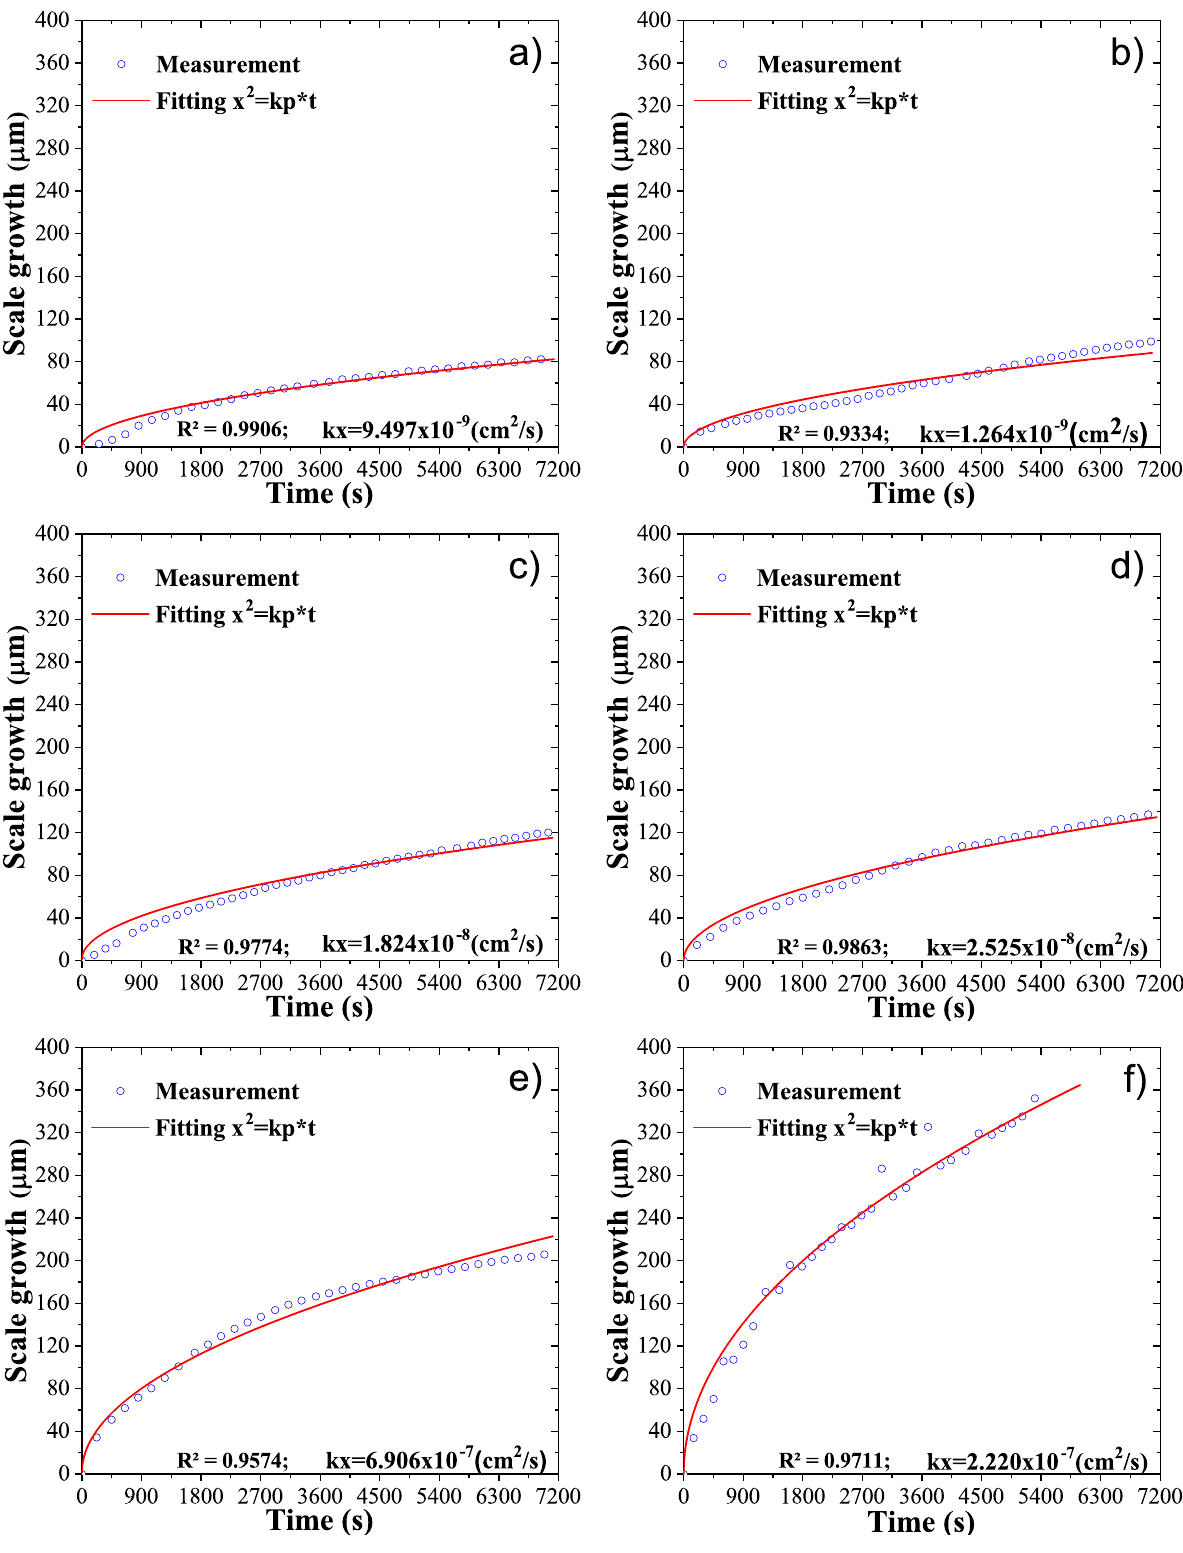
Figure 5. Oxide layer growth at different temperatures ( a ) 800 ◦ C, ( b ) 850 ◦ C, ( c ) 900 ◦ C, ( d ) 950 ◦ C, ( e ) 1000 ◦ C, and ( f ) 1050 ◦